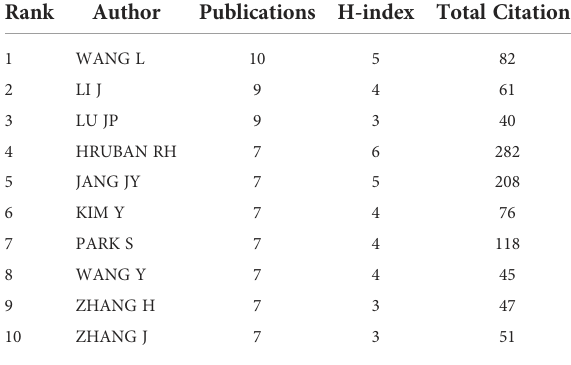
TABLE 3 Top 10 productive authors on AI in pancreatic